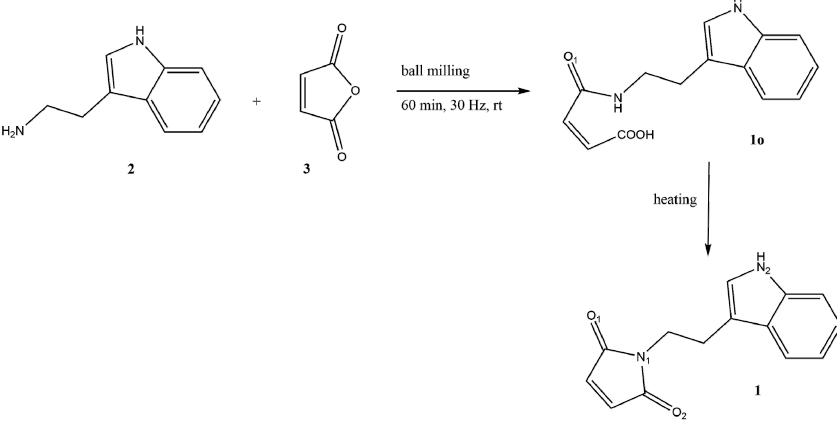
Figure 1. Synthetic route to 1 , using a solvent-free mechanosynthetic approach.